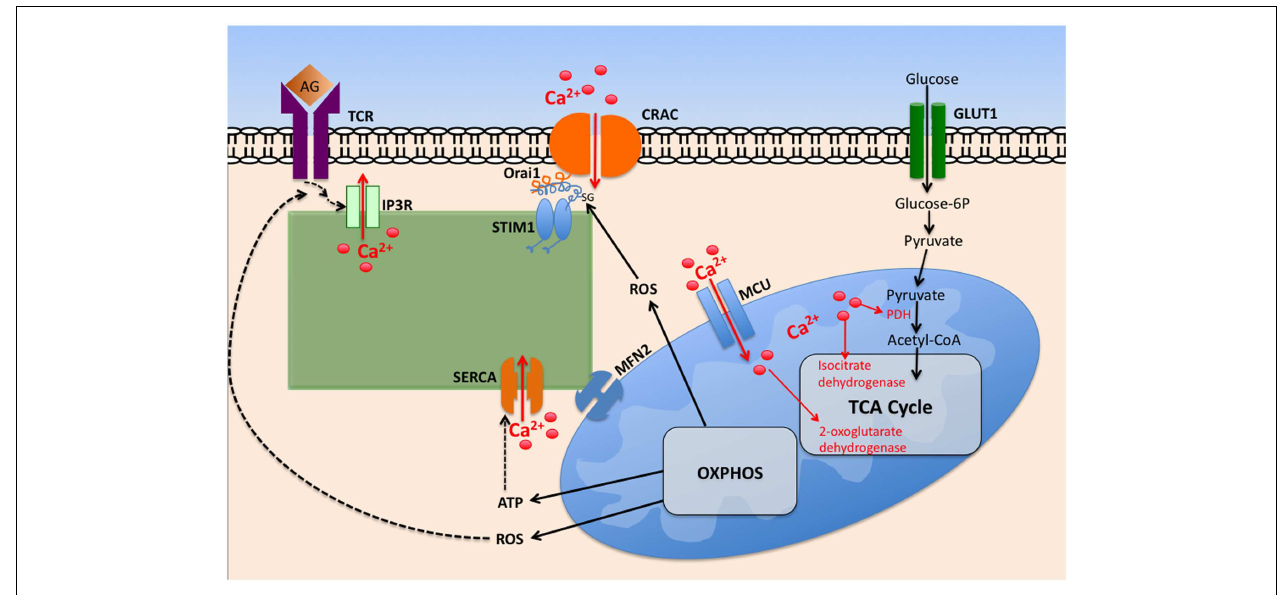
mitochondrial calcium uniporter (MCU). Elevated matrix Ca 2 + enhances the activity of key tricarboxylic acid cycle (TCA) enzymes, leading to elevated oxidative phosphorylation (OXPHOS), and ATP generation. Reactive oxygen species (ROS) byproducts of OXPHOS enhanceTCR proximal signaling by inhibiting tyrosine phosphatase activity. Elevated cytosolic ROS governs CRAC activity by ROS mediated modification of cysteine residues exposed on